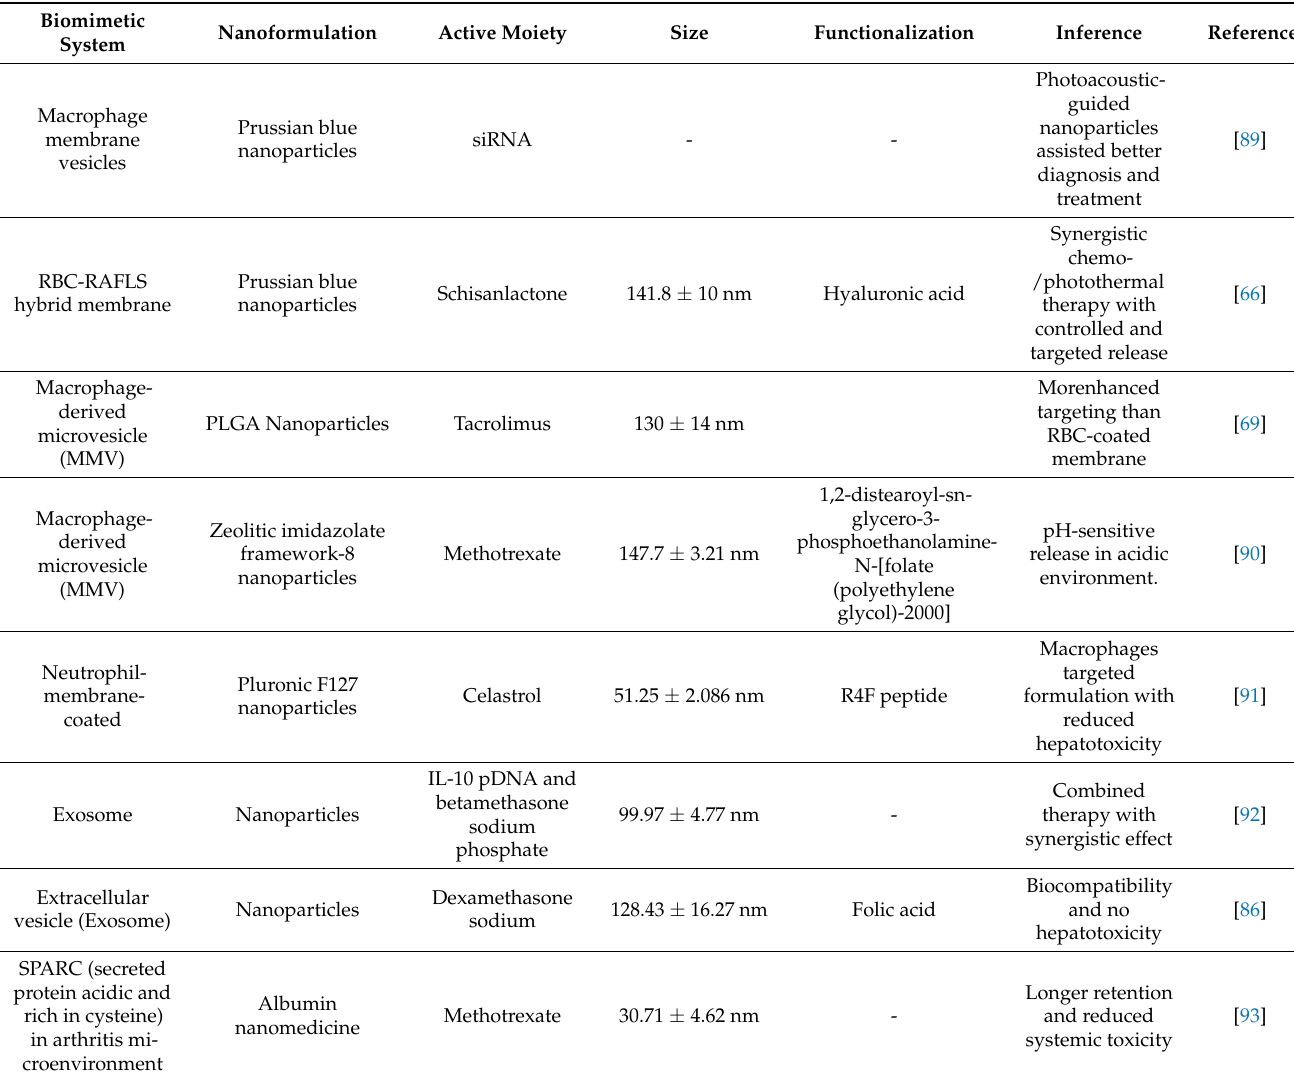
Table 2. List of biomimetic nanomedicines for the treatment of